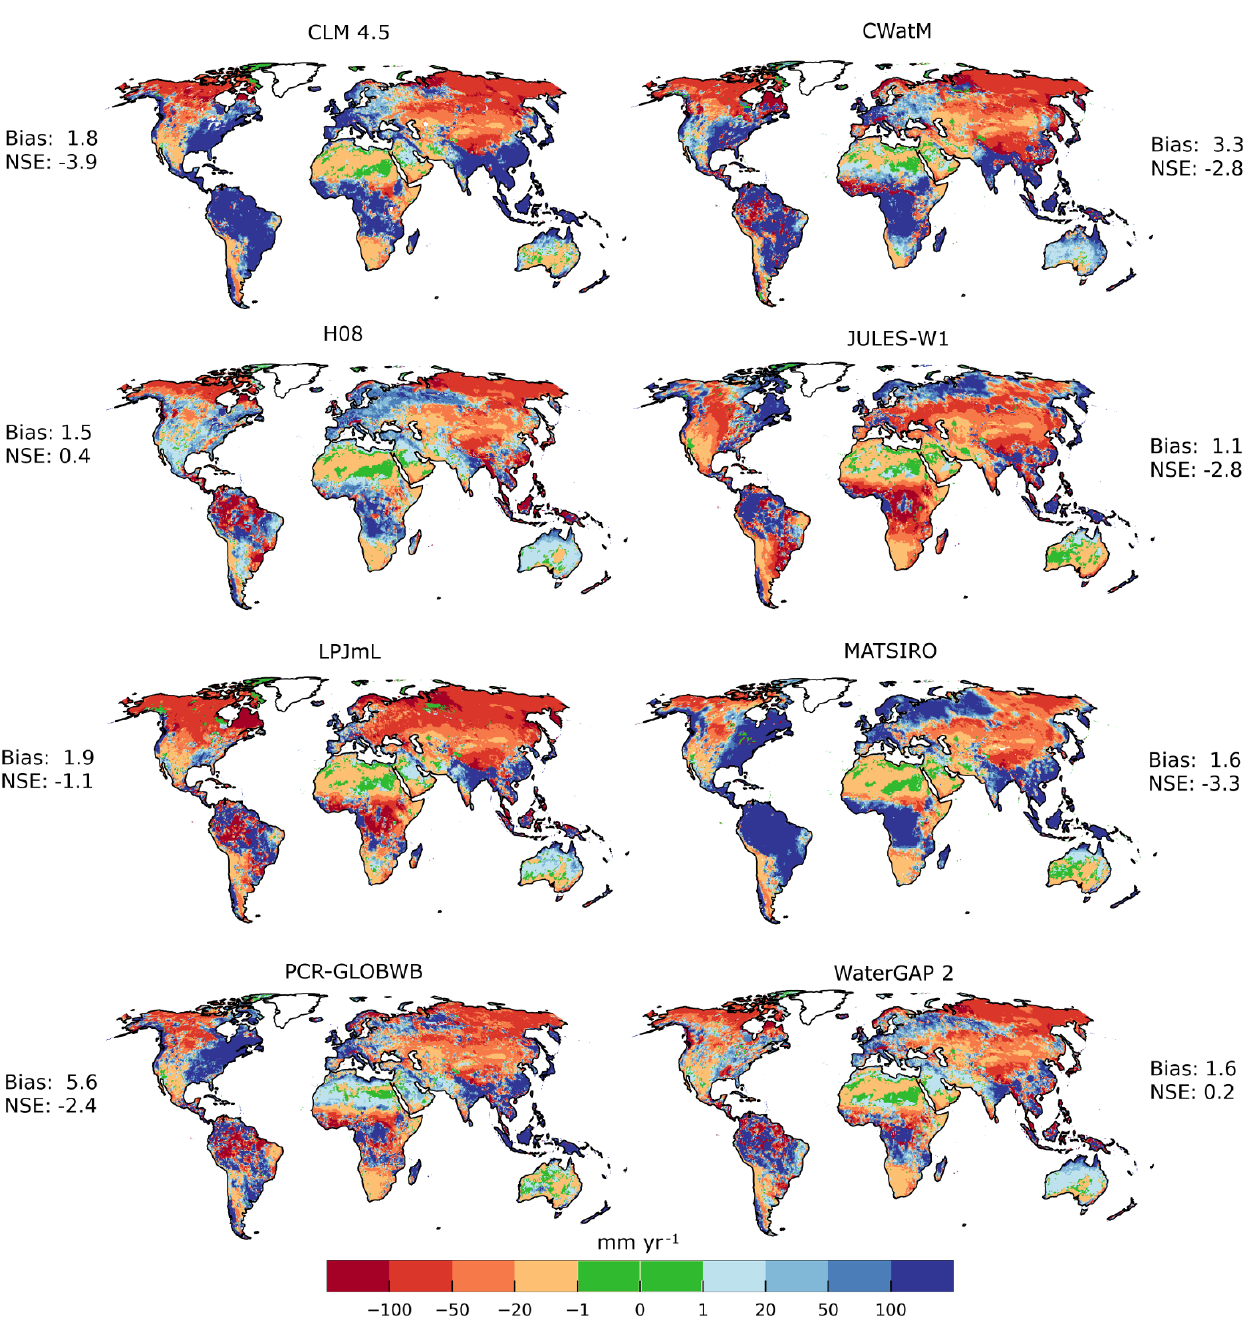
Figure 9. PI GWR per GHM compared to the 34-year (1981–2014) mean GWR (mmyr − 1 ) of Mohan et al. (2018). Bias is the mean (GHM / Mohan et al. 2018). NSE (Nash–Sutcliffe efficiency; Nash and Sutcliffe, 1970) is calculated spatially over all cells instead of